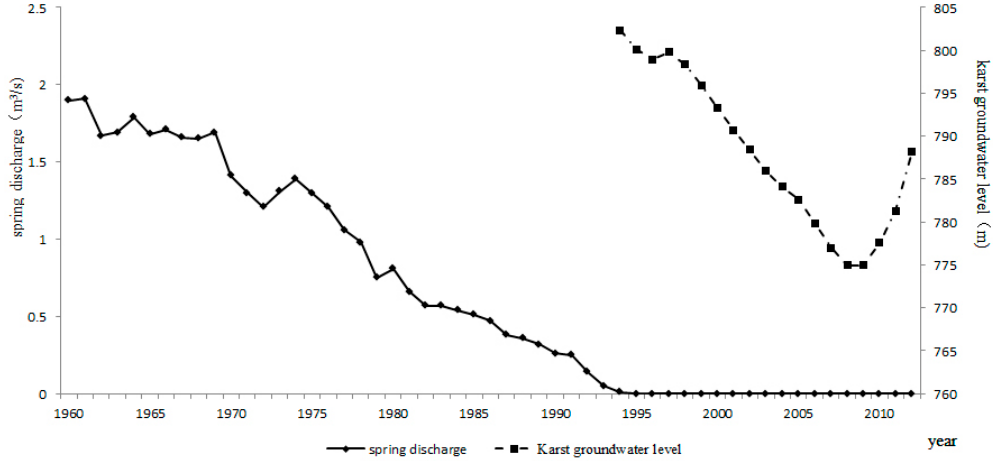
Figure 2. The change trend chart of Jinci Spring discharge and the karst groundwater level of the spring vent.